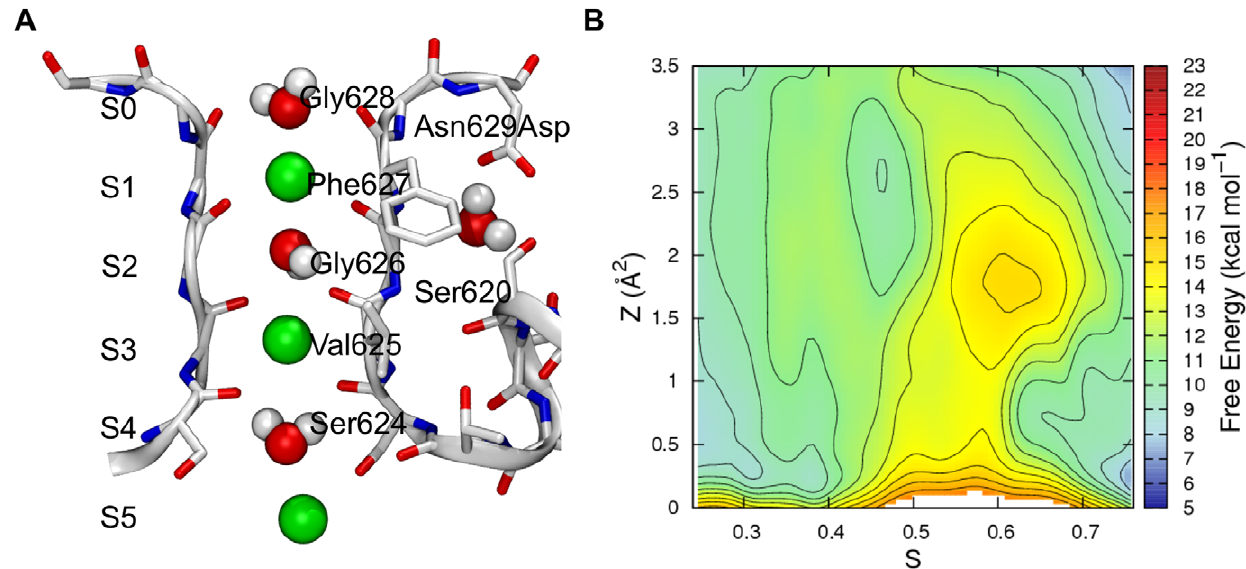
Figure 6. Effect of negatives charges behind the filter. A, the SF of the Asn629Asp mutant. B, Free energy of ion conduction as a function of S and Z calculated for the mutant. The free energy surface is shown as contour plot using an iso-line separation of 1 kcal mol 2 1 .